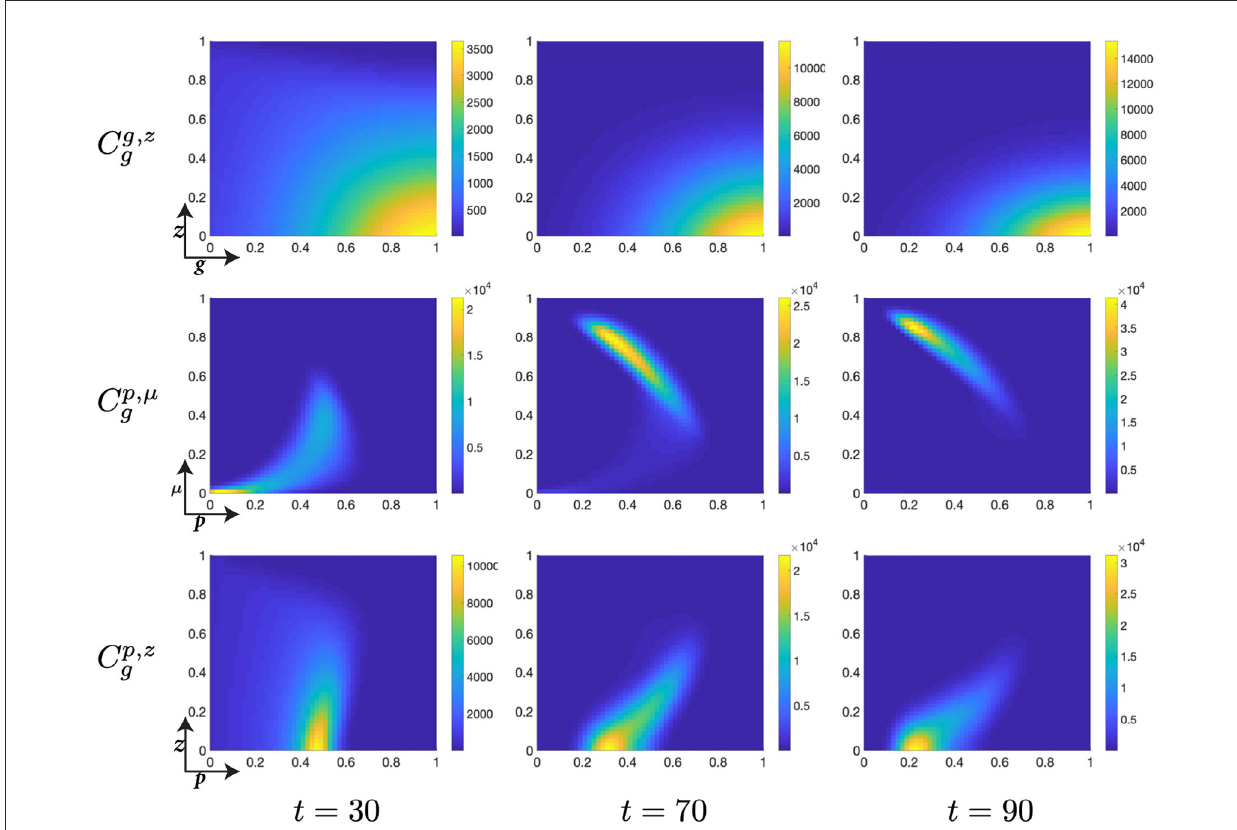
FIGURE13 Structured G-phase cell population given in: the G-cyclin-DNA-damage plane ( g , z ); the p53-mdm2 plane ( p , µ ); and the p53-DNA-damage plane, with a reduced mutational repair rate ( χ z